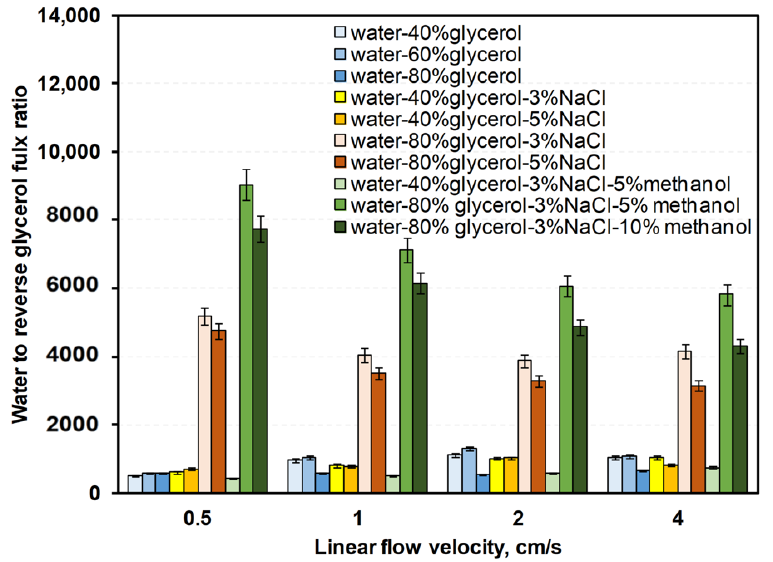
Figure 8. Water-to-reverse glycerol mass flux ratios for various linear flow velocities in counter- current FO with different water–glycerol–salt–methanol draw solutions.